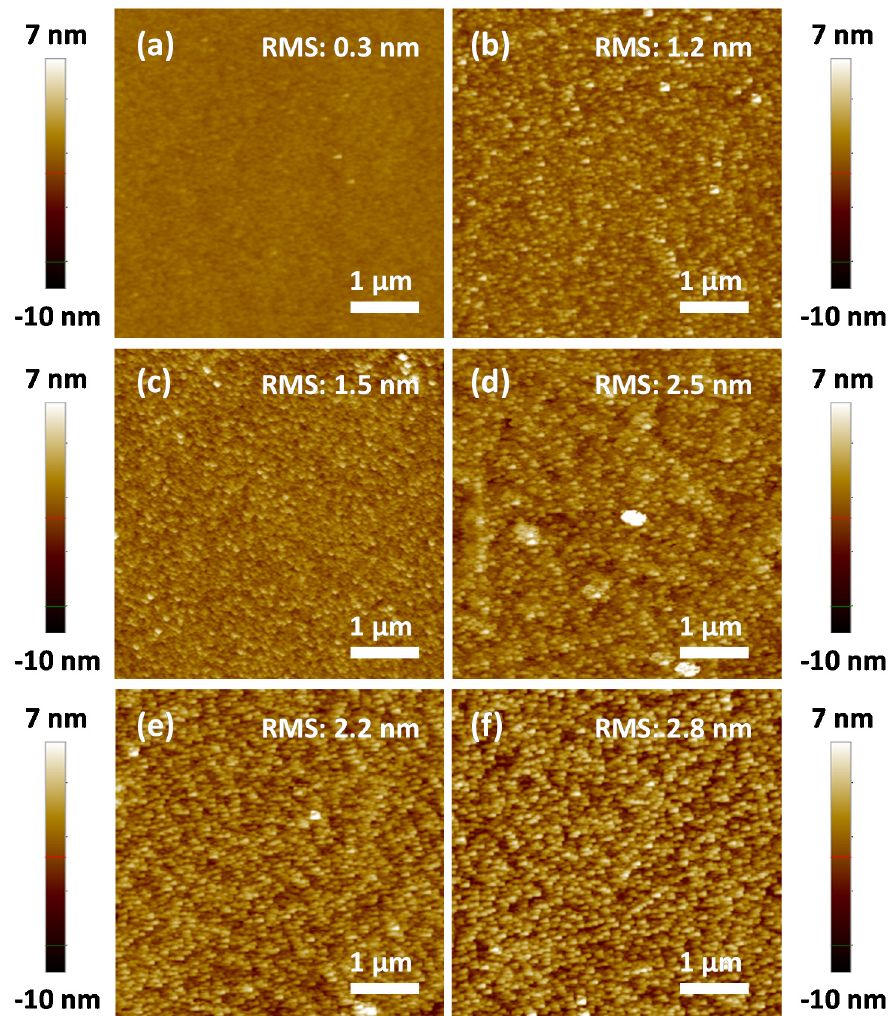
Figure 3. (a–d) AFM surface images of different as-deposited SnS thin films. ( a ) SnS-30, ( b ) SnS-50, ( c ) SnS-80, and ( d ) SnS-100. ( e , f ) AFM surface images of ( e ) SnS-80-H250 and ( f ) SnS-80-H300.